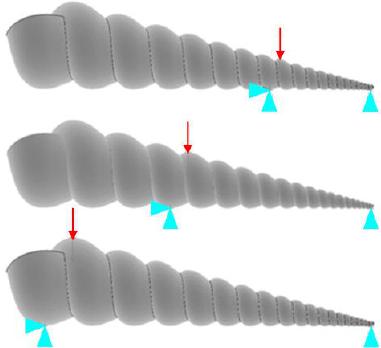
Figure 7. Three-point bending model with pin-roller connections acting upon a simulation of one shell at three different stages of growth.